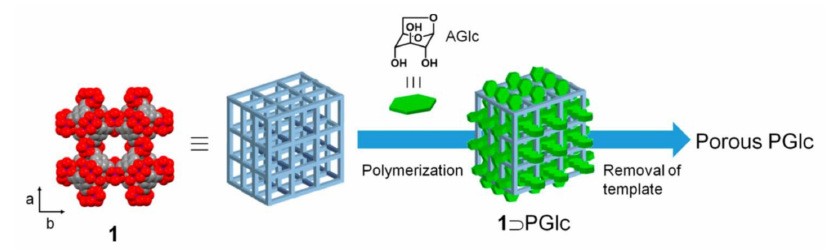
Figure 16. Scheme showing the polymerization of porous polyglucose using MOF HKUST-1 as the host matrix. View of three-dimensional nanochannels of HKUST-1 displayed using a space-filling model (O, red; C, gray; Cu, blue) [95]. Copyright 2017, American Chemical